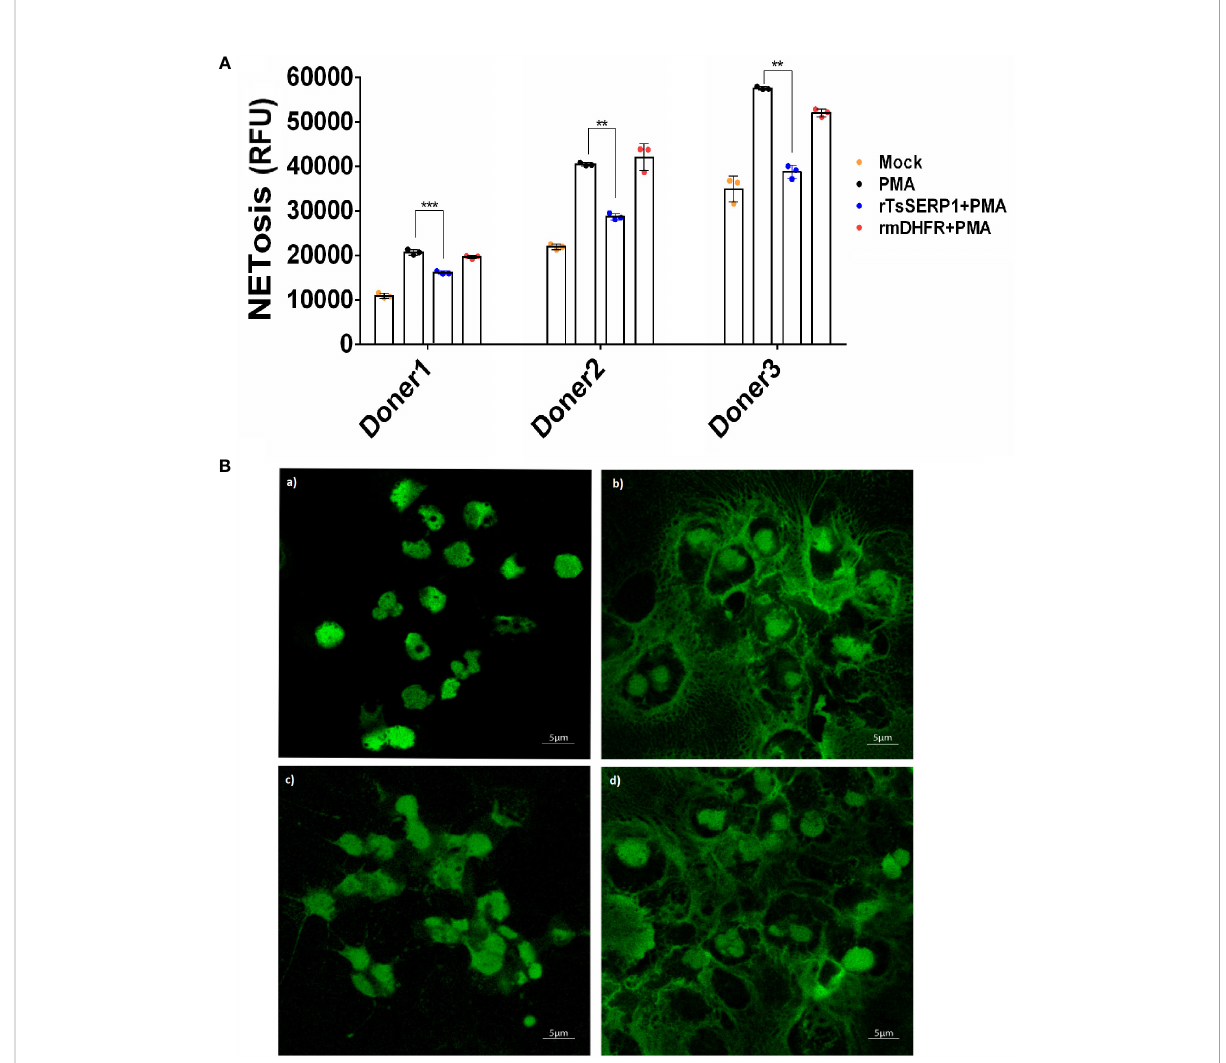
FIGURE 4 rTsSERP1 inhibits neutrophil extracellular traps (NETosis). Neutrophils initially stained with Sytox green (5 µM) were treated with rTsSERP1 or rmDHFR (10 µg/ml) for 30 min followed by induction with PMA (50 nM) for 4 h. NETosis was analyzed by the quantitative fl uorescence intensity (A) and fl uorescent images (B) with different treatment conditions including media alone (Mock) (a), PMA induction alone (PMA) (b), rTsSERP1 treatment before PMA induction (rTsSERP1+PMA) (c), and treatment with an irrelevant control (rmDHFR) before PMA induction (rmDHFR+PMA) (d). The bar charts show the data of three different donors, which are presented as the mean ± SD. The experiments were performed in triplicate with three independent experiments. One-way ANOVA followed by a Bonferroni multiple comparison test were used for statistical analysis: ** p < 0.01 and *** p <